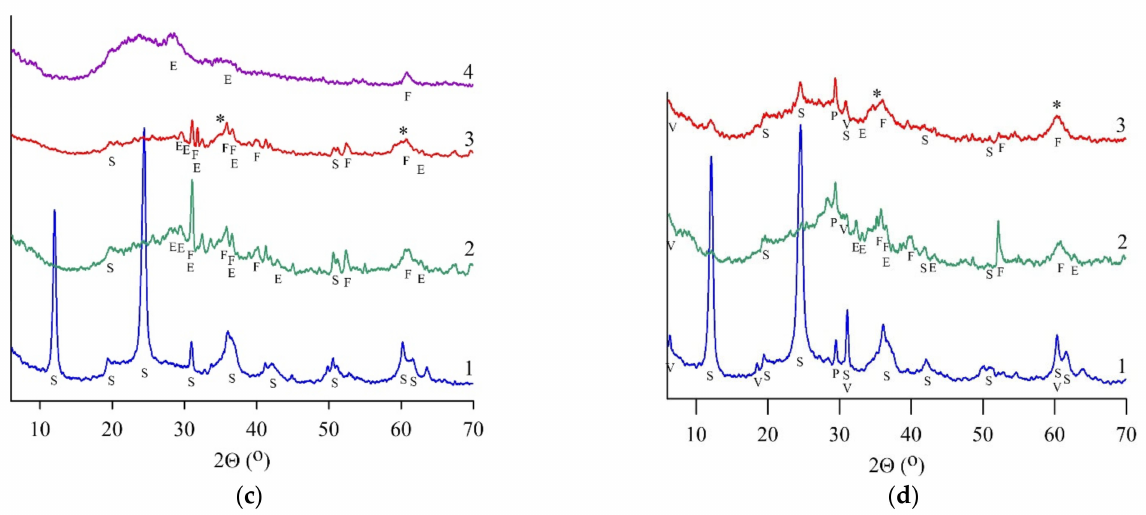
Figure 2. X-ray phase analysis results for serpentine samples: SAP ( a ), SCH ( b ), SLH ( c ), and SLK ( d ); curve for initial (1), heat-treated (2), and hydrated heat-treated (3) samples after 28 days of hardening, (4)—residue after leaching by HCl (8 wt.%). S—serpentine, E—enstatite, F—forsterite, V—vermiculite, H—hematite, O—olivine, P—pyroxene (enstatite), *—magnesium silicate hydrate